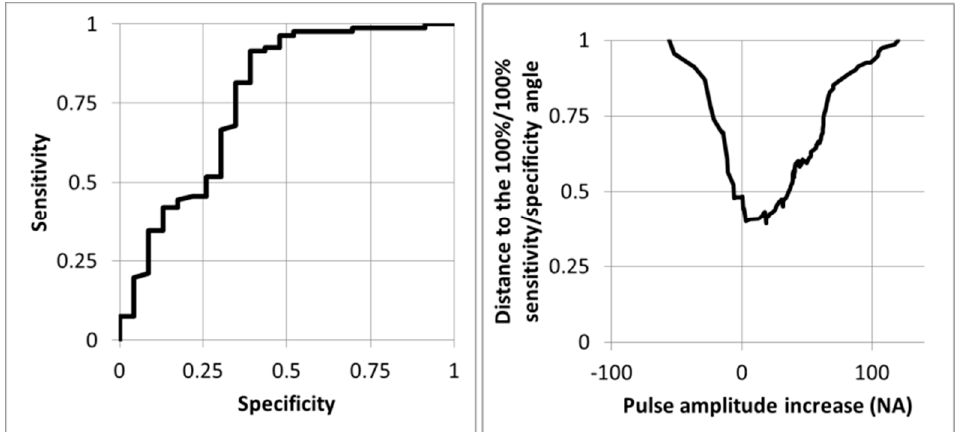
Figure 5. Receiver operating characteristics curve (left panel) and distance from the 100%/100% sensitivity/specificity angle (right panel) for the prediction of the presence of an arterial compression at imaging (ultrasound +/ − angiography) for the 104 upper limbs using the change in pulse amplitude whereby the 100 normalized amplitude (NA) is the amplitude observed during the prayer phase of the candlestick-prayer maneuver. As shown, the optimal cut-off point is a pulse amplitude increase of 3 NA.